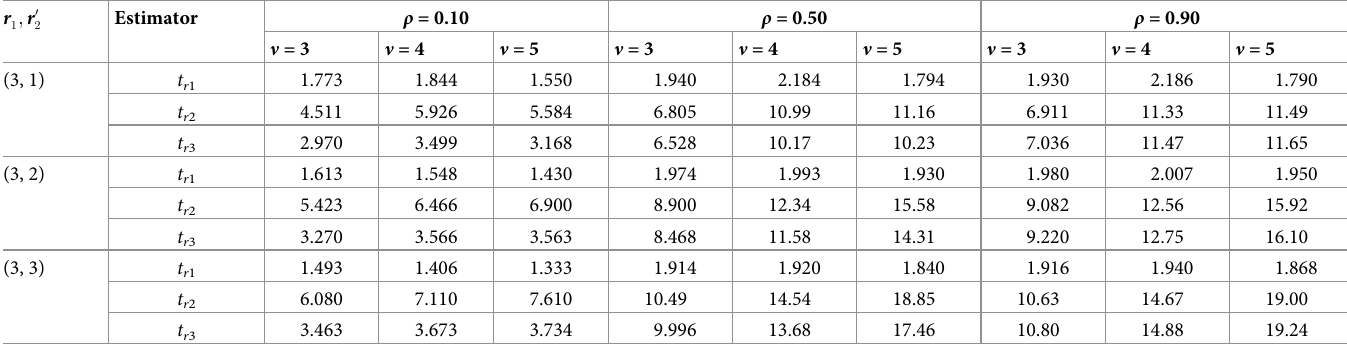
Table 5. RE of proposed class of estimators for Situation-II when k =